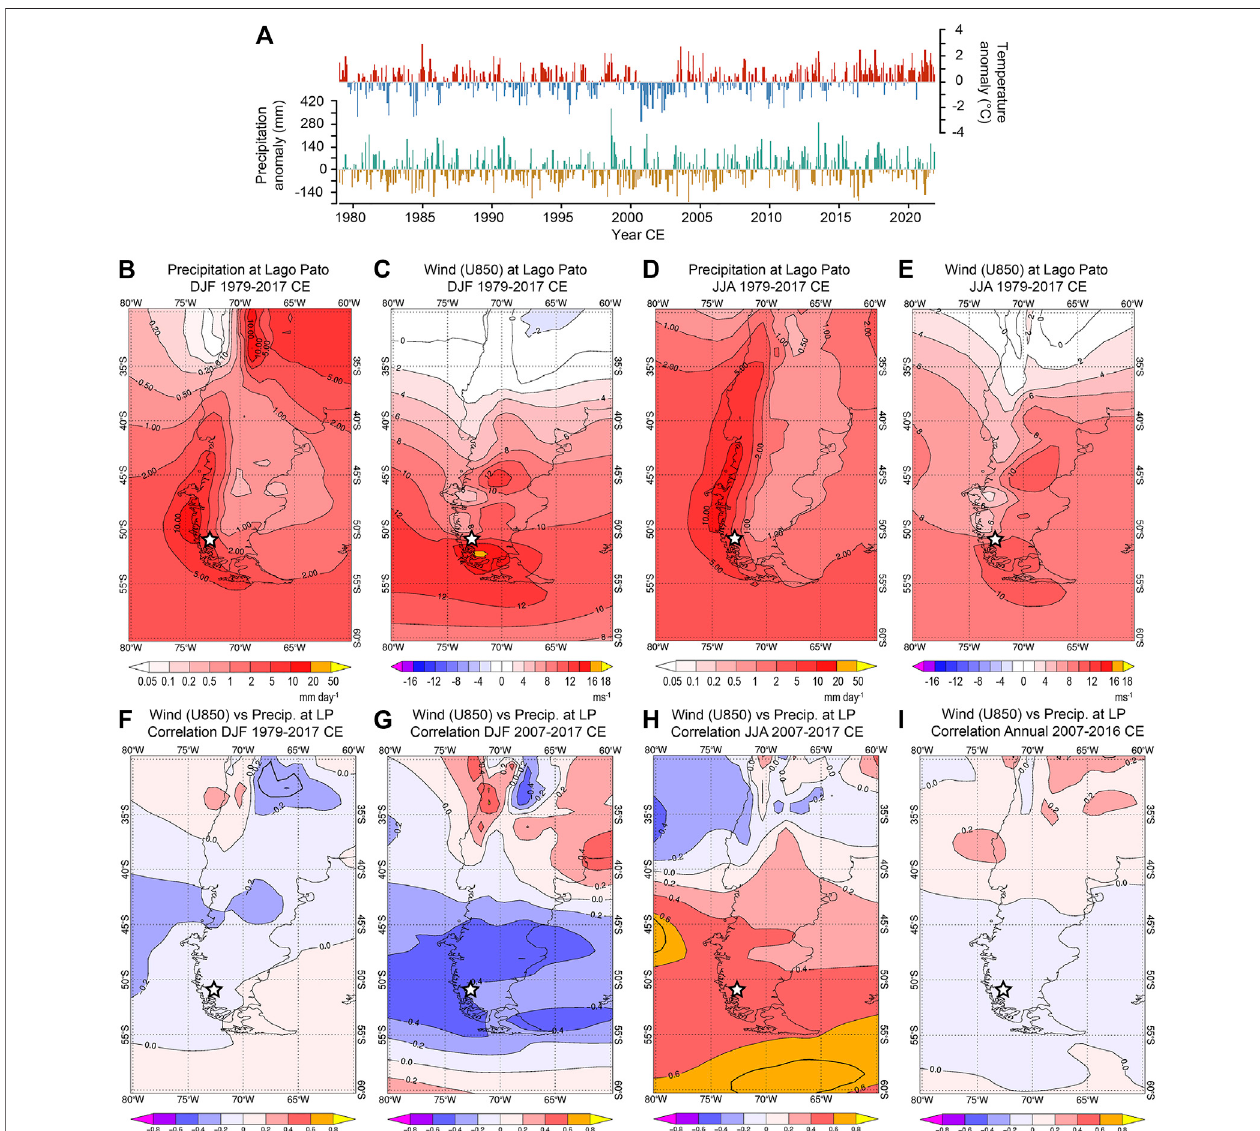
FIGURE 4 | (A) Temperature and precipitation anomaly data from Parque Nacional Torres del Paine meteorological station between 1979 and 2021. Data generated from and copyright of https://www.meteoblue.com, used here with permission. (B – E) ERA-INTERIM reanalysis (Dee et al., 2011) for mean Austral summer (December – January – February; DJF) and winter (June – July – August; JJA) mean surface precipitation (mm per day; 1/12/1979 – 1/3/2017) and zonal wind speed (U on P at 850-hPa over the Andes in ms − 1 ; 1/12/1979 – 1/3/2016) over southern South America (30 – 60 ° S) between 1979 and 2017 CE. The white star is the location of Lago Pato. (F) ERA-INTERIM reanalysis data showing neutral to marginally negative correlation coef fi cients between mean zonal wind velocity over southern South America and mean surface precipitation at Lago Pato for the austral summer (DJF) from 1/12 to 1/3 between 1979 and 2017 CE compared to (G) increasingly negative time mean correlation coef fi cients over Lago Pato for the austral summer (DJF) from 1/12 to 1/3 between 2007 and 2017 CE and (H) positive time mean correlation coef fi cients at Lago Pato for the austral winter (JJA) from 1/6 to 1/9 between 2007 and 2017 CE. (I) Time mean correlation coef fi cient map of annual mean wind velocity oversouthernSouthAmerica(30 – 60 ° S)andannualmeanprecipitation atLagoPato(whitecircle)between1/12/1979and1/12/2016CE.ERA-INTERIMdataandmaps were generated using a BAS internal portal to the Dee et al. (2011) dataset with the fi nal layout made in Adobe Illustrator.